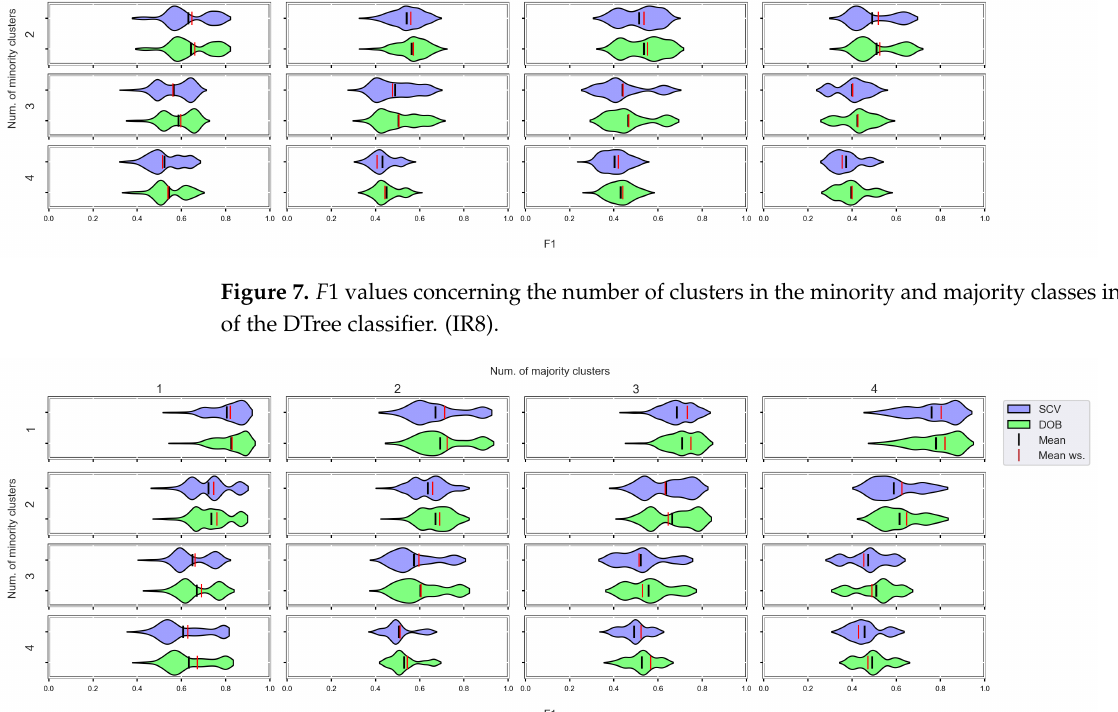
Figure 8. F 1 values concerning the number of clusters in the minority and majority classes in the case of the kNN classifier.